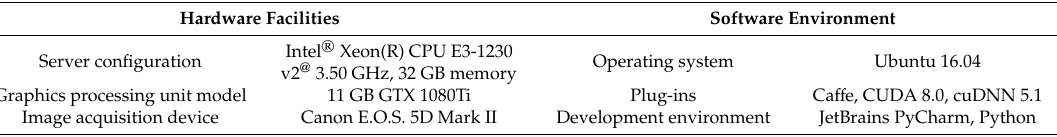
Figure 4. Experimental process of locust image classification. Table 4. Environment of the experimental infrastructure.